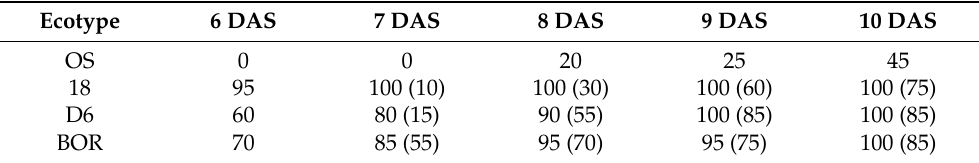
Table 1. Percentage of withered and dried (data in brackets) drought treatment plants from the 5th to the 10th day of the experiment ( n = 20).